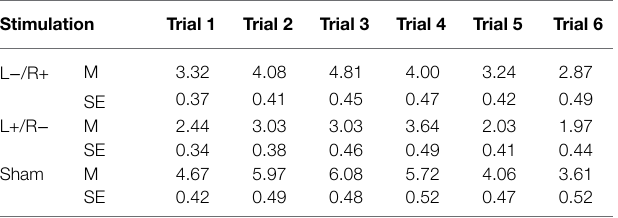
TABLE 2 | Mean (M) and SE of regret dataset under three